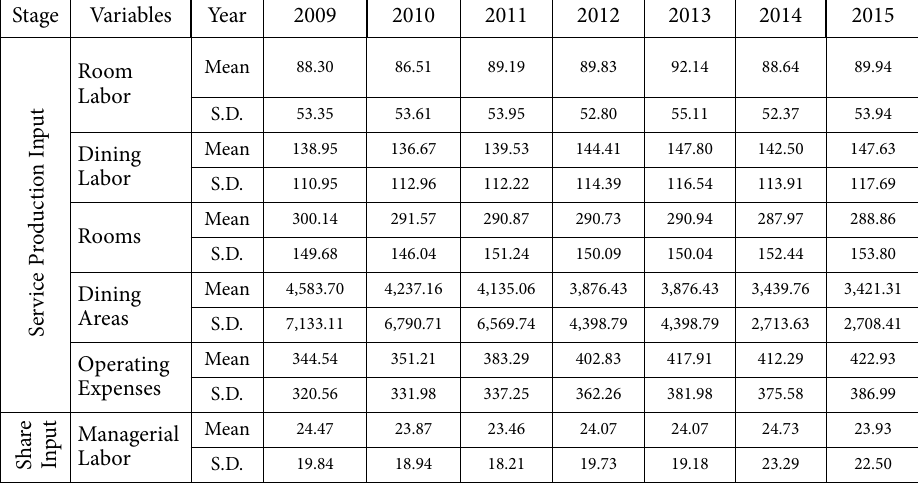
Table 2. Descriptive statistics of Taiwanese international tourist hotels Stage